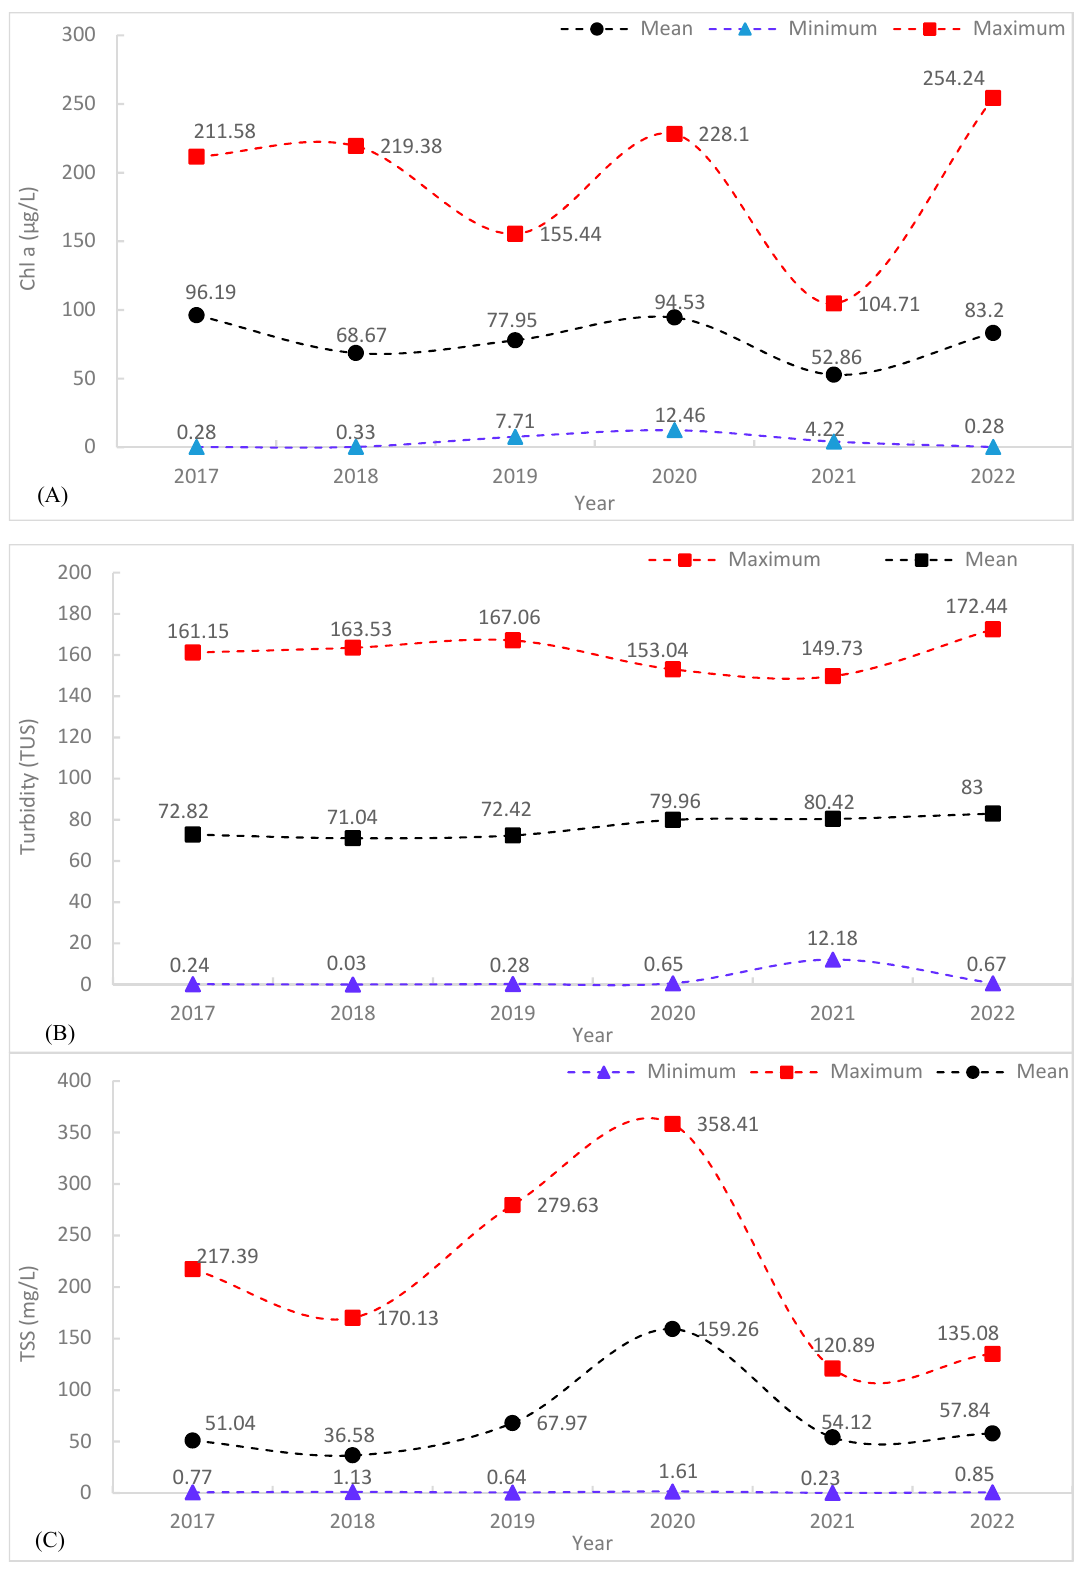
Figure A5. Yearly temporal WQPs from Sentinel 2A satellite image using linear regression models.